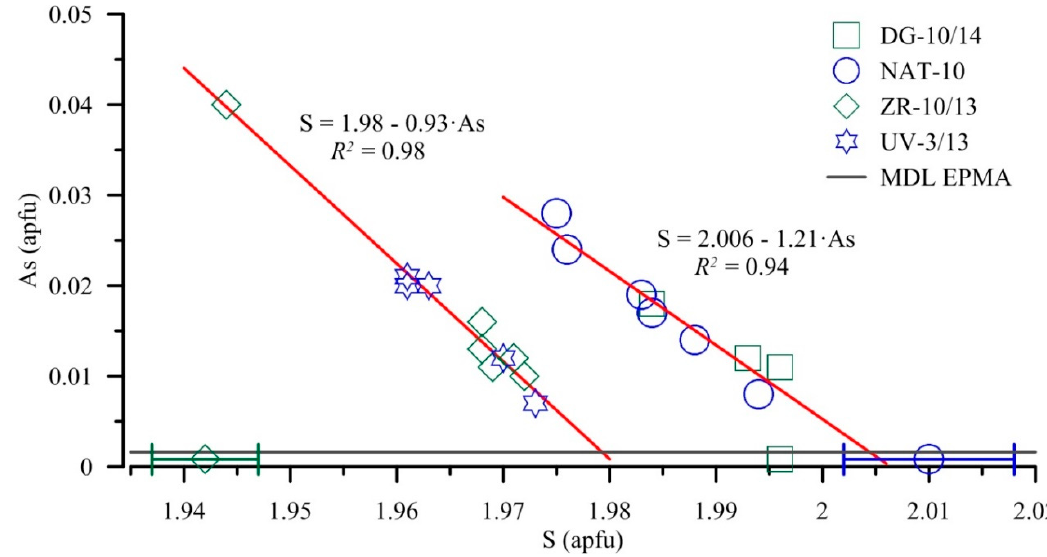
Figure 4. Two types of S–As correlation in As–pyrite. The “stoichiometric trend” gives Fe / S = 2.006 when extrapolated to “pure” (As-free) pyrite, whereas the “nonstoichiometric trend” gives Fe / S = 1.98 and, moreover, does not correlate with “pure” pyrite which is still more nonstoichiometric.